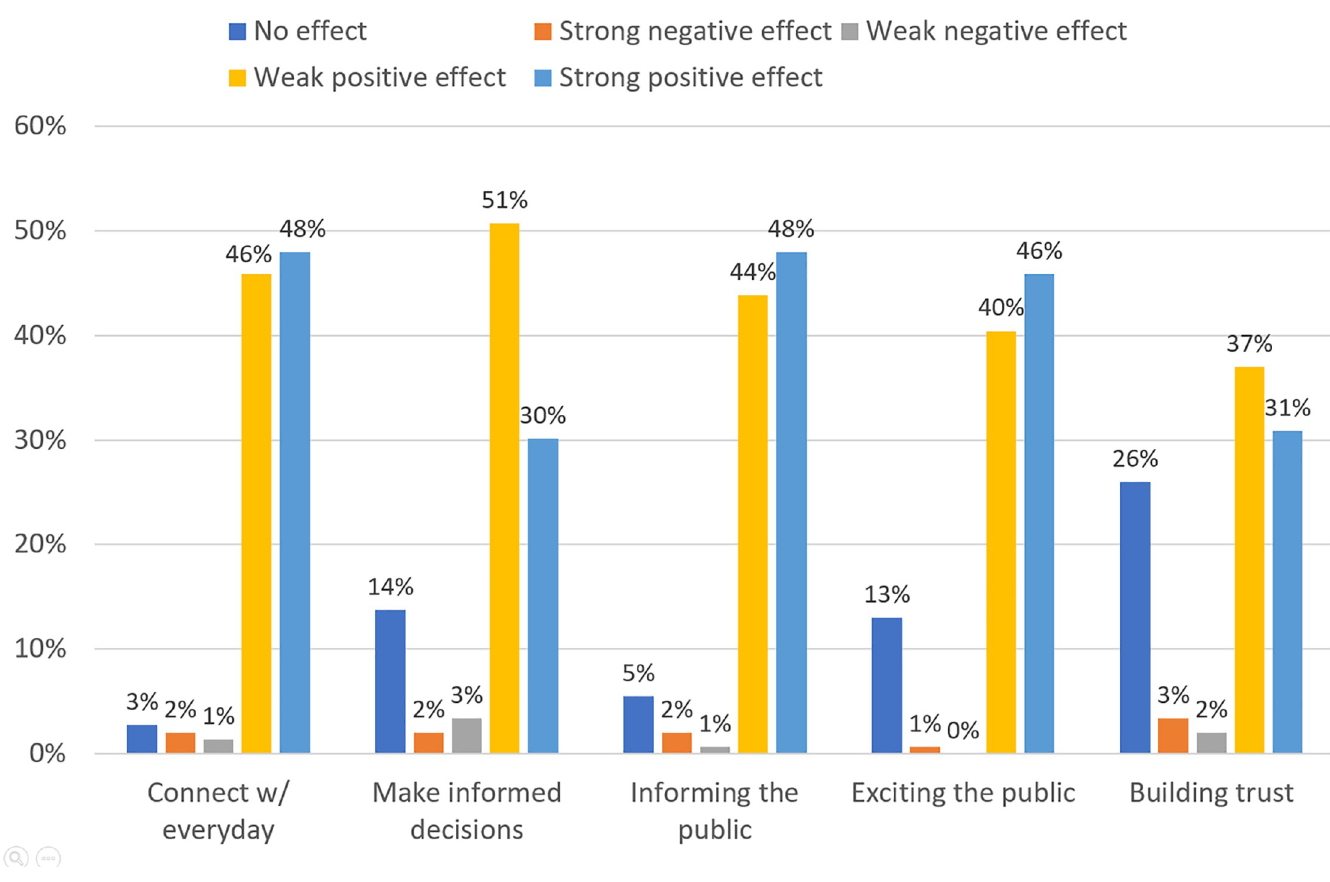
Fig 4. Perceived effects of r/science